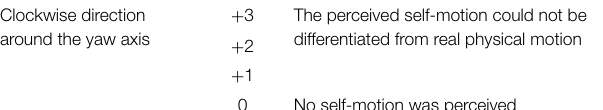
+ 3 The perceived self-motion could not be differentiated from real physical motion + 2 + 1 0 No self-motion was perceived